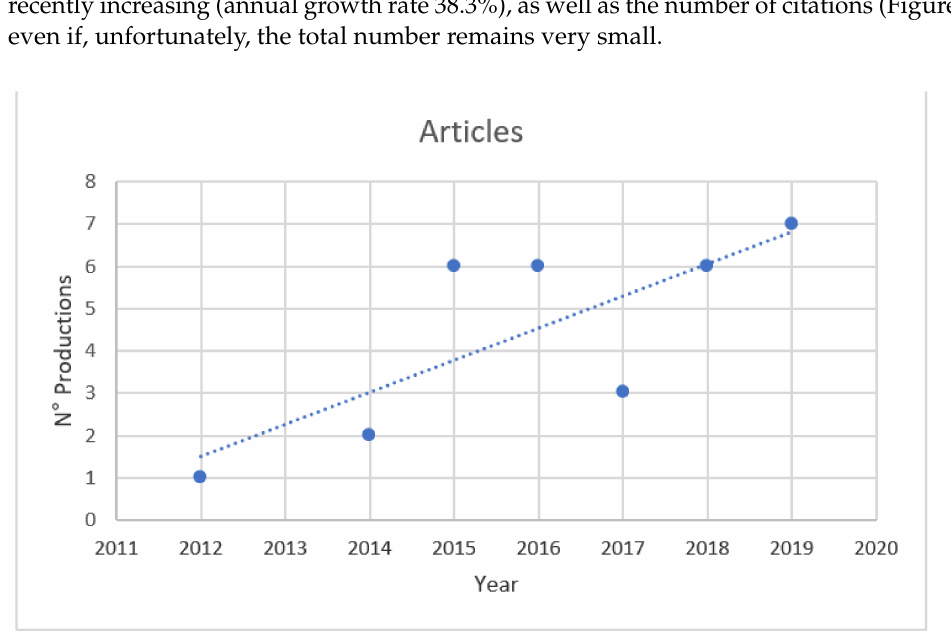
Figure 1. Annual scientific production. The annual growth rate shows 2012 as the starting year of publications in this field, growing exponentially since 2015 with a little collapse in 2017 and a subsequent rebound in 2018 (worthy to note that however the number of products remains very small). Blue dots correspond to the